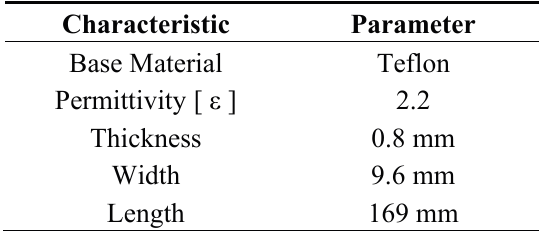
Table 1. Characteristics of the proposed wireless access for vehicular environment antenna